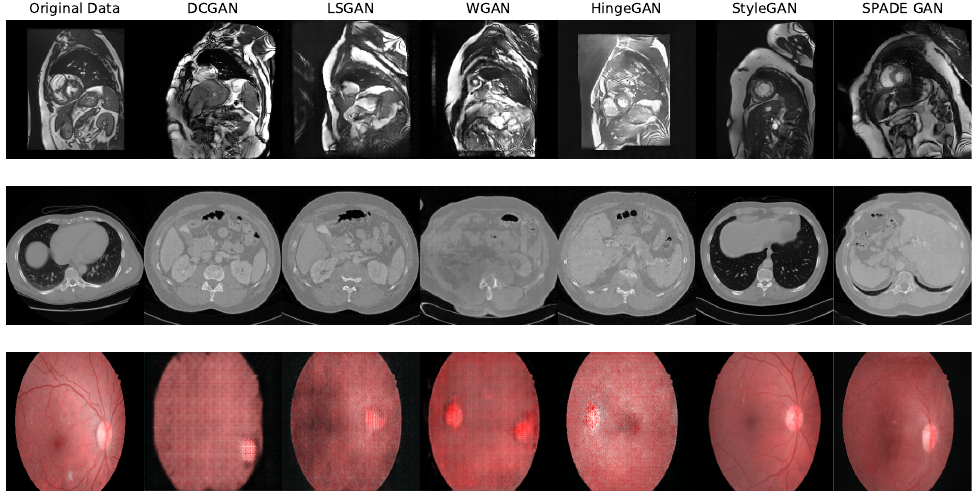
Figure 4. Examples of generated images for each GAN on the ACDC, SLiver07, and IDRiD datasets. The first column is an example image from the real dataset. High resolution versions of these images are available in the Supplementary